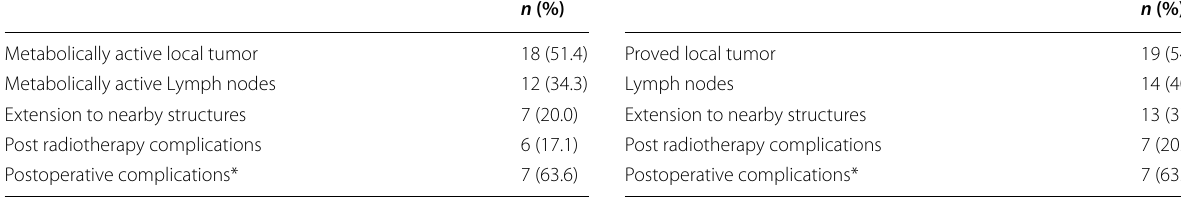
*Percentage was calculated based on total 11 patients underwent